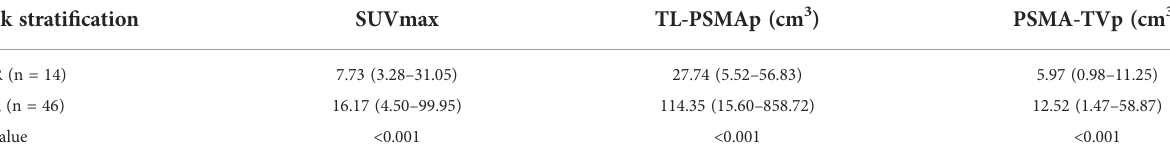
p- value <0.001 <0.001 <0.001 Non-normally distributed data are presented as median (range). SUVmax,maximumstandardizeduptakevalue;PSMA,prostate-speci fi cmembraneantigen;TL-PSMAp,prostatetotallesionPSMA;PSMA-TVp,prostatePSMA-tumorvolume;LIR,low- intermediate-risk; HR, high-risk; PET, positron emission tomography.